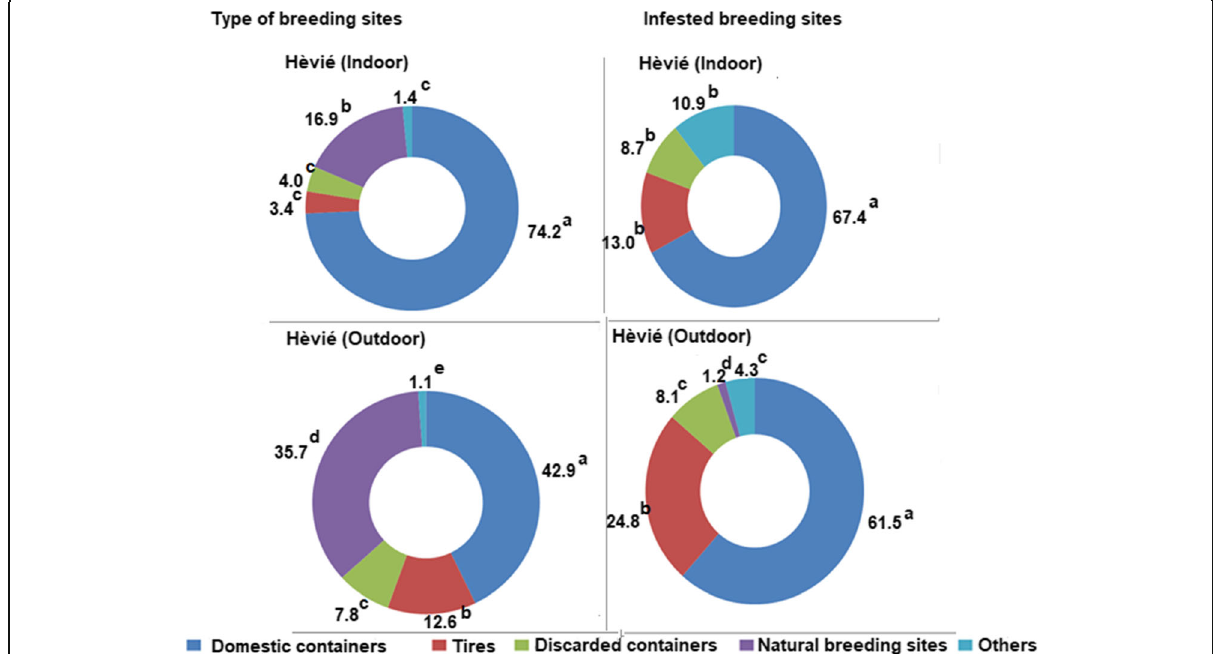
Fig. 3 Proportion of potential and positive of breeding site types located indoors and outdoors in HêviéFor a same parameter, parts of a same circle diagram with values holding different superscripts are significantly different ( p <